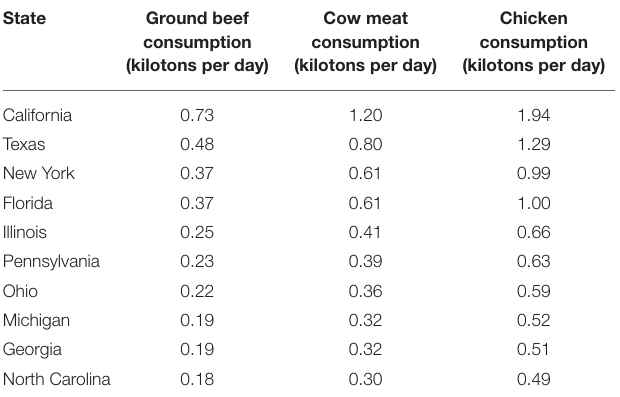
TABLE 5 | Top 10 states with cow meat, ground beef, and chicken consumption